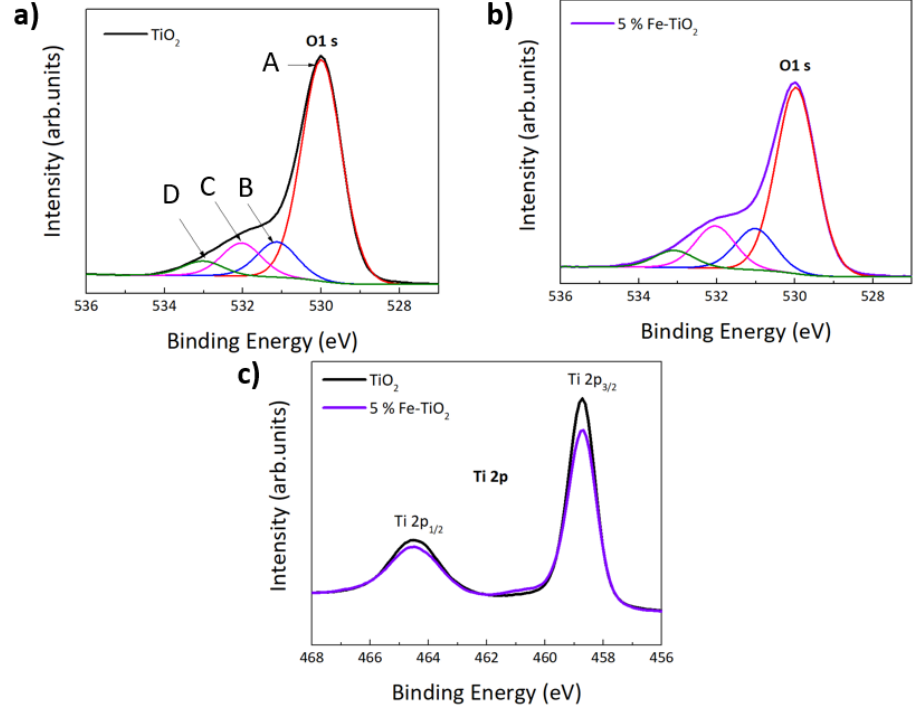
Figure 5. Deconvolution of XPS O 1s spectra of ( a ) pure TiO 2 , where features A, B, C and D are visible and correspond to lattice oxygen, undercoordinated oxygen either at the surface or close to oxygen vacancies and adsorbed water and organic species, respectively, and ( b ) 5% Fe ‐ TiO 2 nanostructures with PEG. Ti 2p peak is also shown in ( c ) for pure TiO 2 and 5 % Fe ‐ TiO 2 nanostruc ‐ tures with